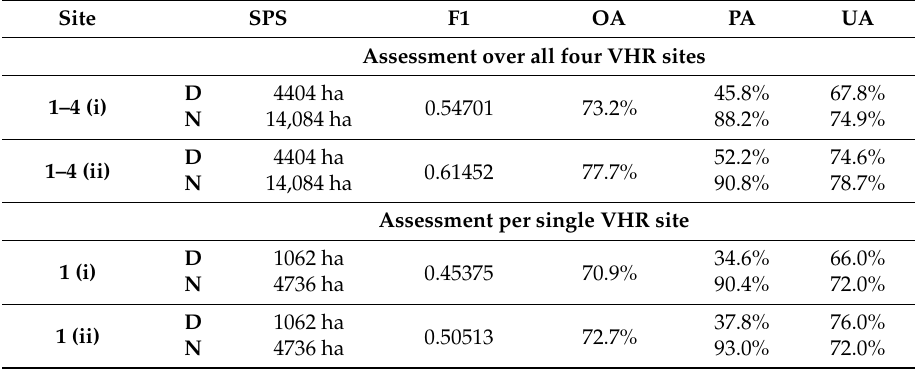
Table 3. Results of accuracy assessments of the ∆ rNBR products (0.02 threshold) derived for the four VHR study sites; (i) refers to the results of accuracy assessment type i; (ii) refers to assessment type ii; D = disturbance stratum; N = no disturbance stratum; SPS = stratum population size; F1 = F1 score; OA = overall accuracy; PA = producer accuracy; UA = user